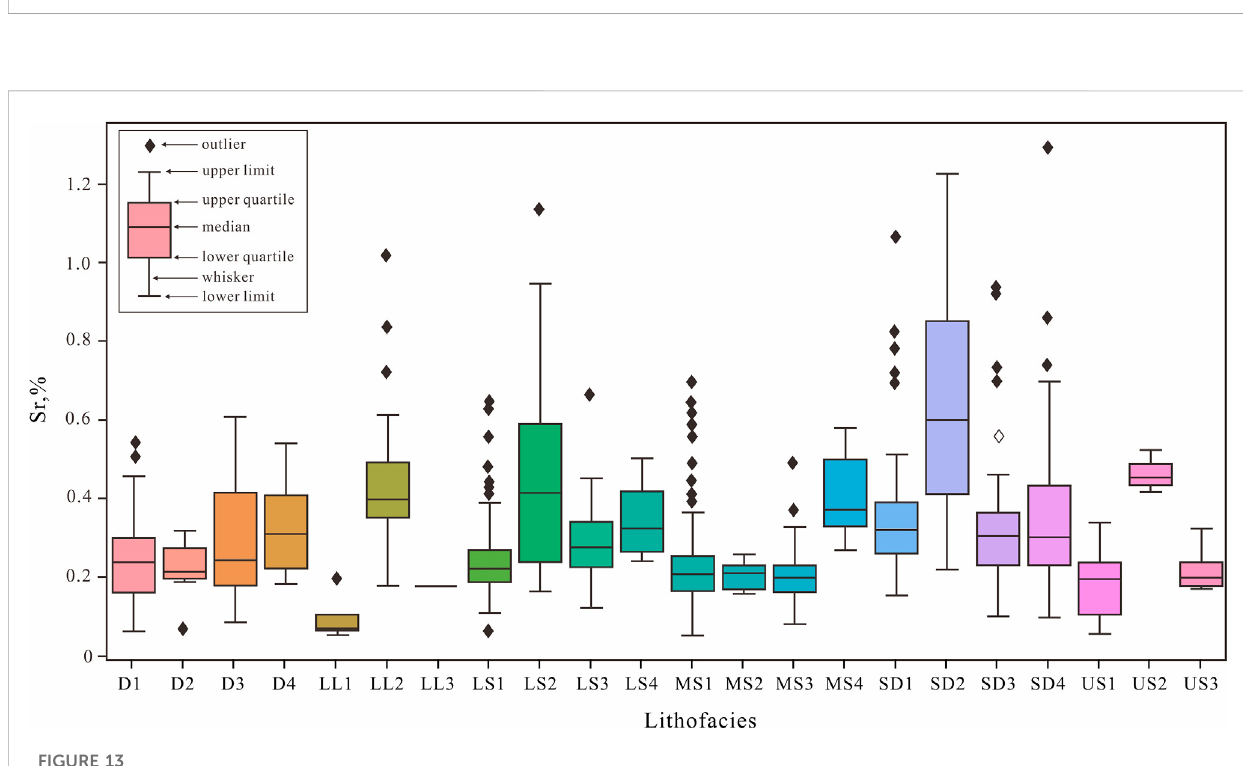
FIGURE 13 Boxplot of Sr content for different lithofacies